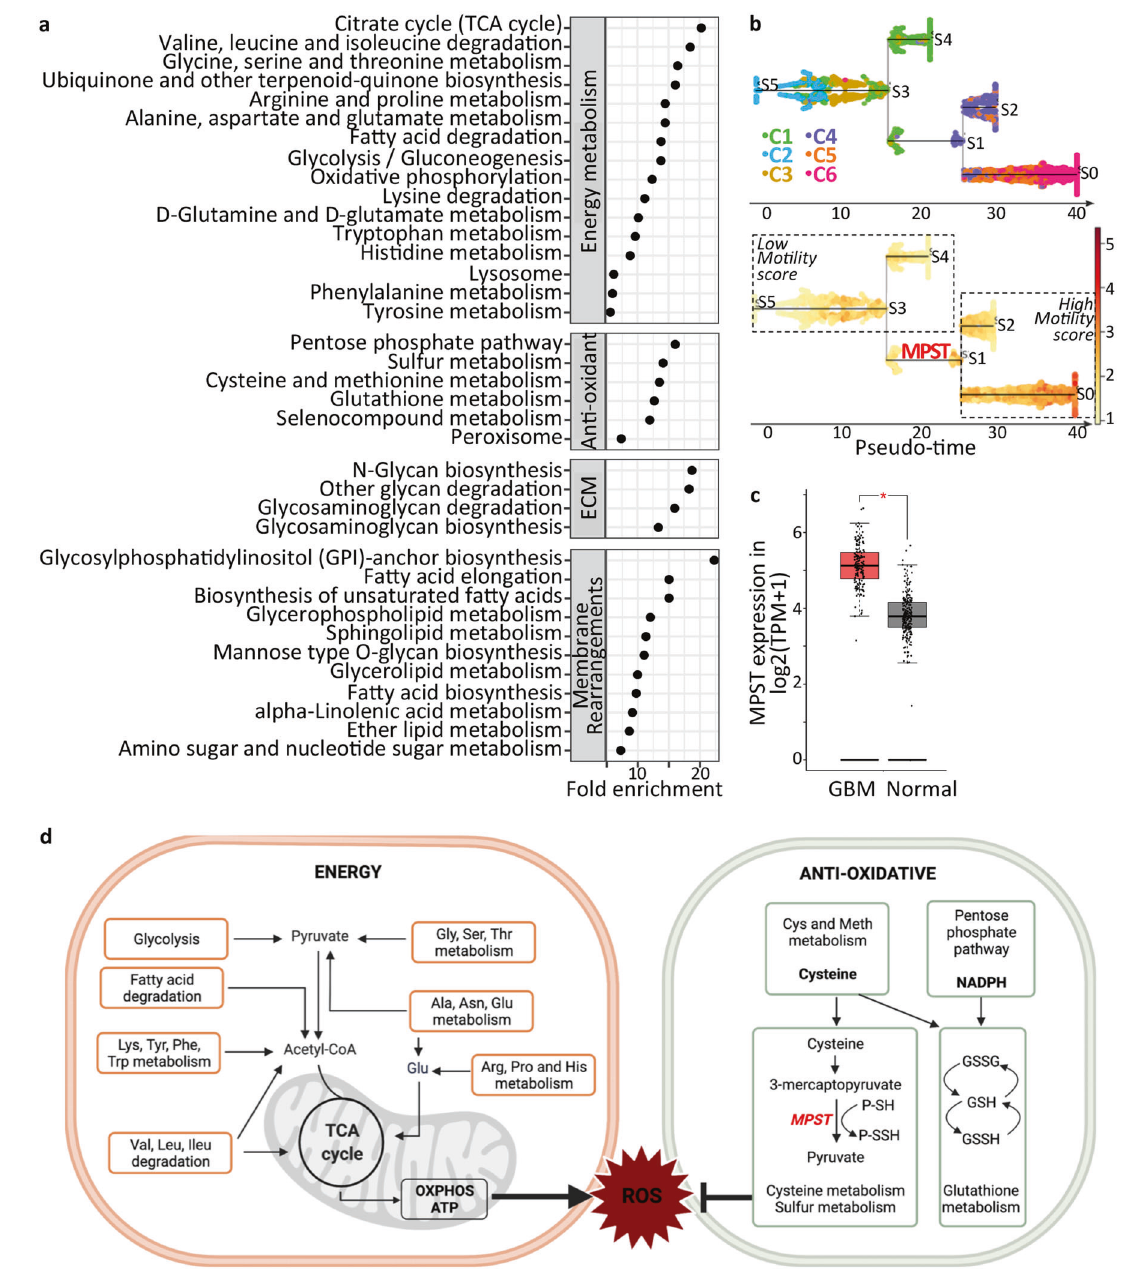
Fig. 2 Metabolic reprogramming of cells with high motile potential. a KEGG pathway analysis of metabolism genes overexpressed in M HIGH cells versus M LOW cells highlights enrichment in pathways involved in energy production, oxidative stress response, extracellular matrix (ECM) modeling, and membrane composition rearrangements. BH-adjusted p -value < 0.05. N-S dataset analysis. b Inferred trajectory of GB cells from low to high motility. Cells colored by motility clusters (top panel) and motility score (bottom panel). MPST marks the path crossroad between low and high motile potential. N-S dataset analysis. c MPST overexpression in GB tissues ( n = 163) versus normal brain tissues ( n = 207). TCGA RNA-seq dataset, GEPIA2 website. One-way ANOVA test, *BH-adjusted p -value < 0.05. d Schematic representation of the metabolic pathways overrepresented in M HIGH cells compared to M LOW cells (created with BioRender.com). See also Tables S4 and